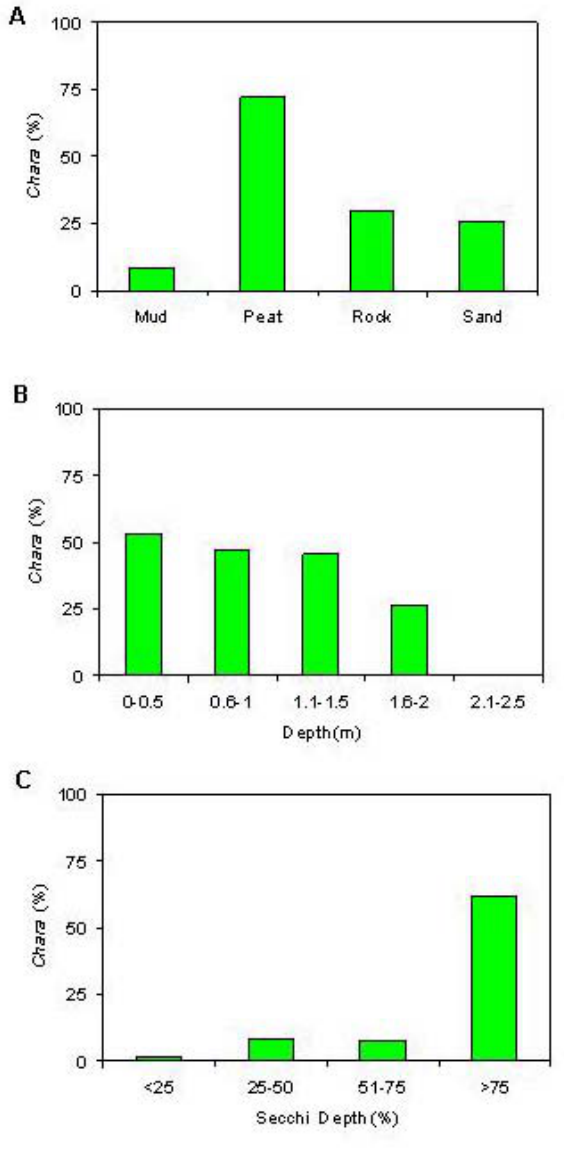
FIGURE 3 . Relationship between occurrence of Chara spp. in the near-shore region of Lake Okeechobee in late summer 2000 and (A) sediment type; (B) water column depth; and (C) Secchi depth, as a percent of water column